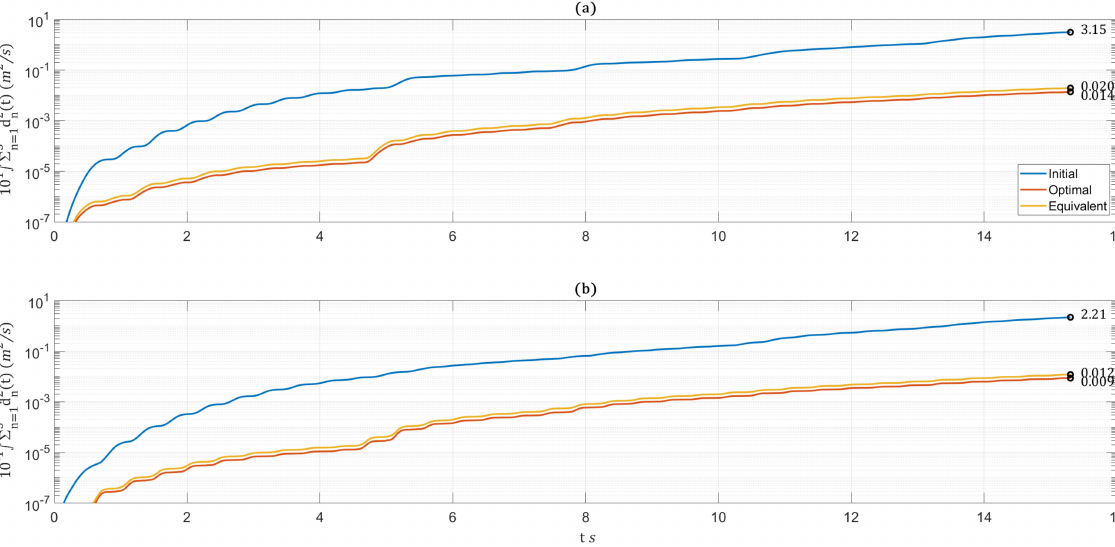
Figure 15. Trajectories of the 15-story inelastic rigid frame system: ( a ) interstory drift ( b ) interstory drift